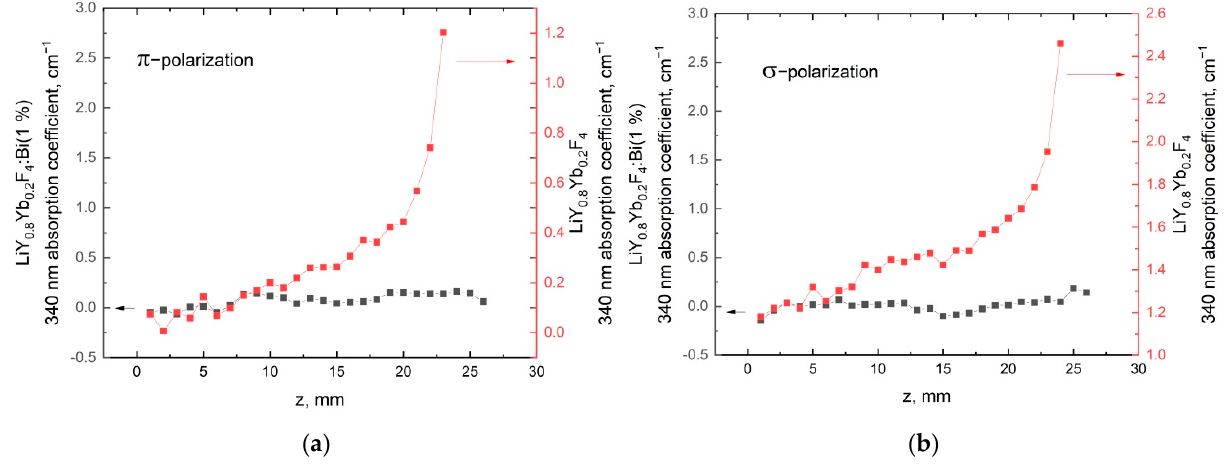
Figure 5. Absorption coefficient at 340 nm along theLiY 0.8 Yb 0.2 F 4 crystals grown from the melt, with and without 1% of BiF 3 additive for π ( a ) and σ ( b ) polarizations.